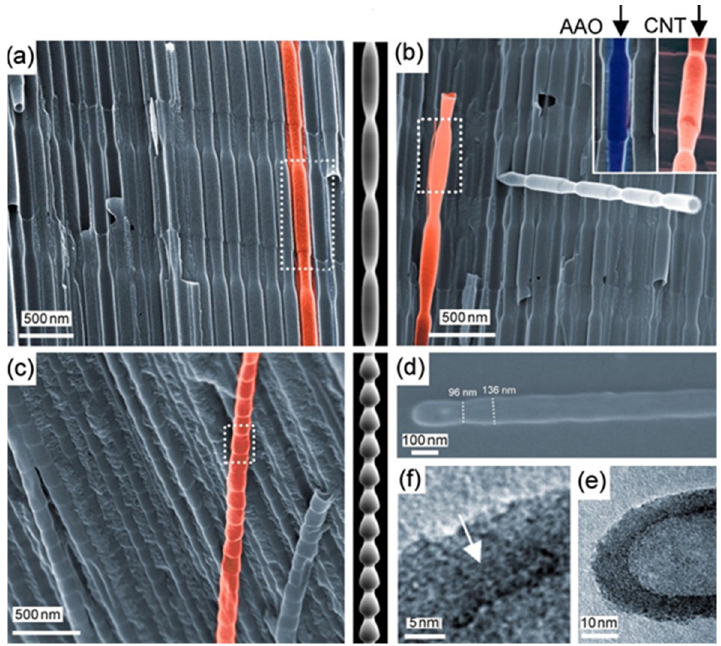
Figure 11. CNTs growth inside PAA templates by a catalyst-free approach with a periodically tailored morphology with ( a ) long, ( b ) middle and ( c ) short segments, this work was performed by the Lusan group. Inset in ( b ) shows the shape of the pore and corresponding CNTs structure. ( d ) Free CNTs with shaped structure and closed bottom after removal of PAA template. ( e , f ) TEM images of CNTs. Reprinted with permission from Ref. [153]. Copyright © 2023 Elsevier Ltd. All rights reserved.